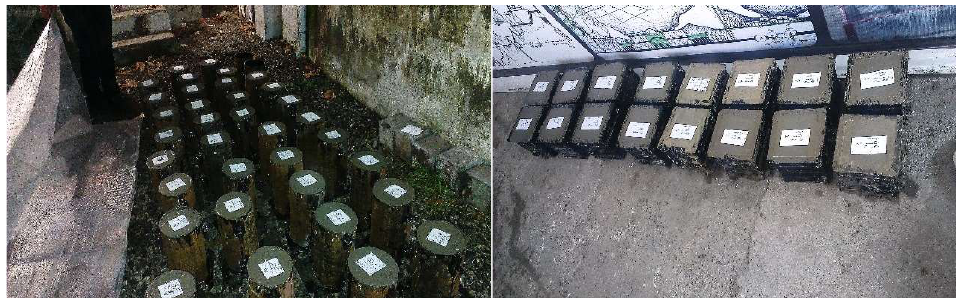
Figure 5. Molding of cylindrical and cubic specimens.